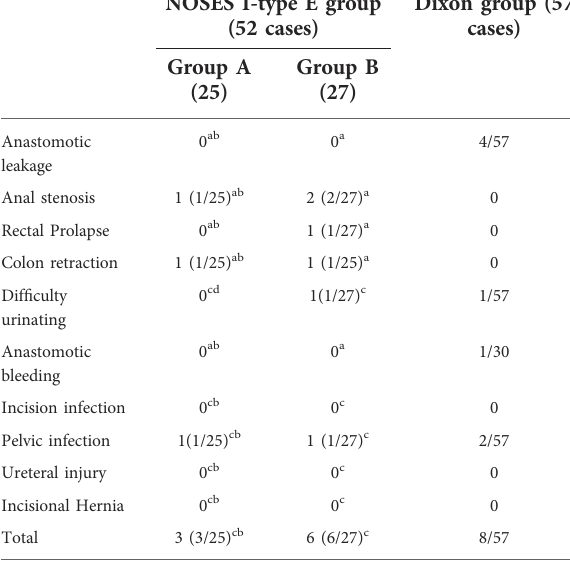
TABLE 2 Comparison of perioperative indicators.